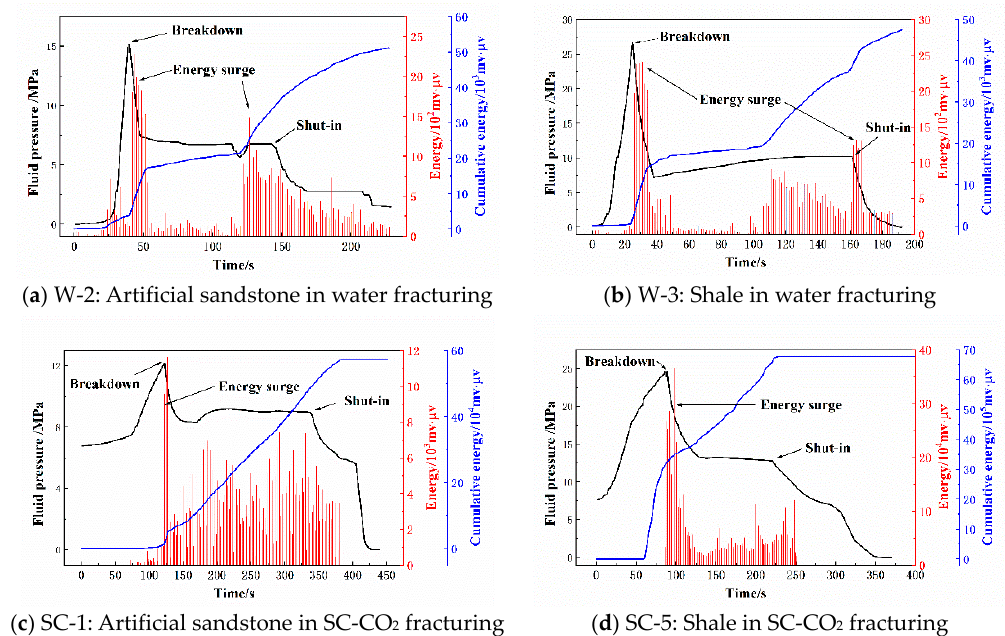
Figure 4. Injection pressure, AE energy, and cumulative energy versus time in water and SC-CO 2